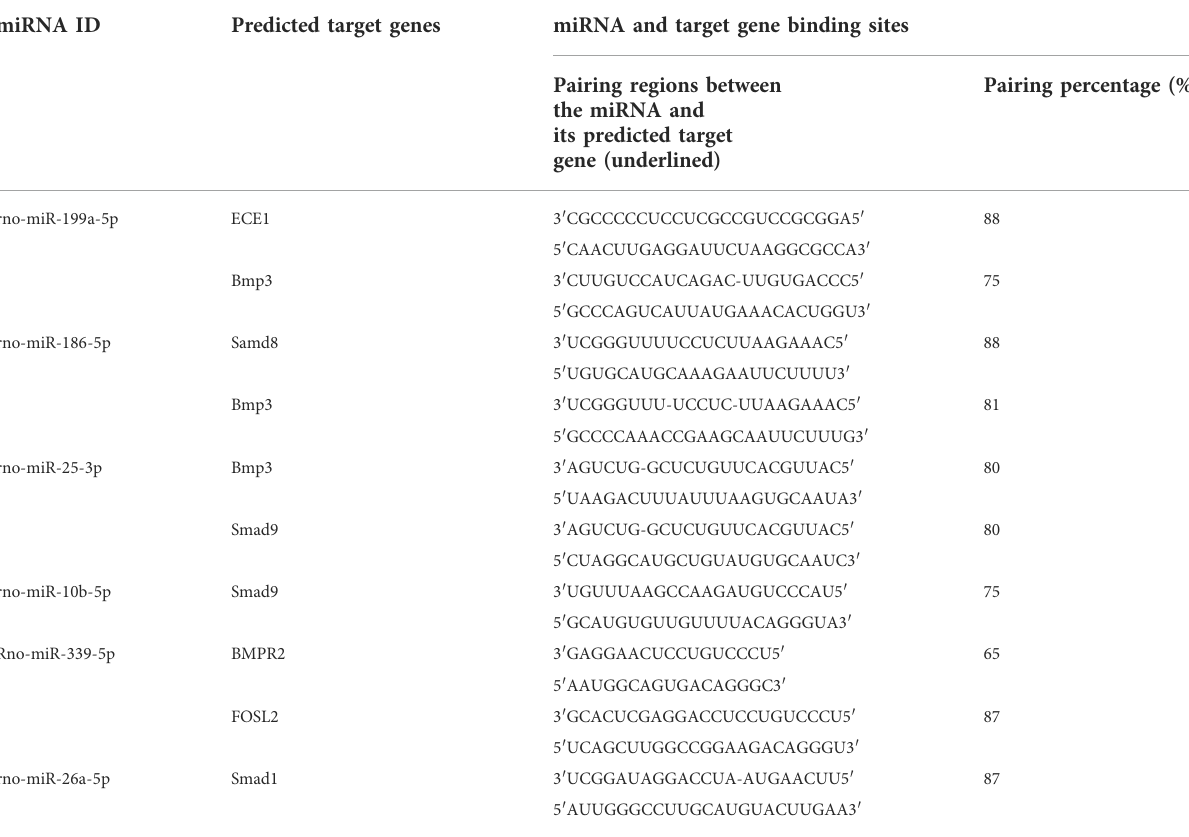
TABLE2Mirandasoftware-predictedosteogenesis-relatedtargetgenesofsomemiRNAsthatshowedsigni fi cantdifferentialexpressionbetweenthe two MCC-Exo groups. miRNA